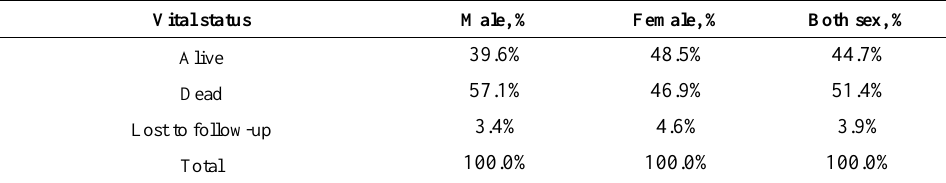
Table 4. Patients by vital status, gender and occurrence of occupational exposure